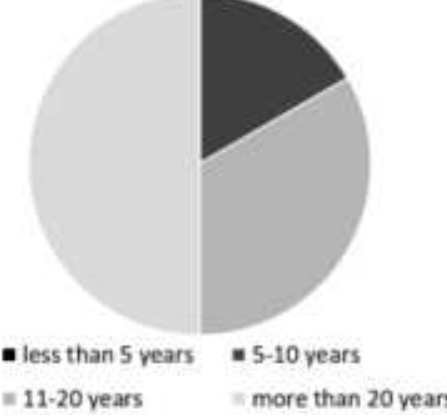
Figure 1. Years of experience of the